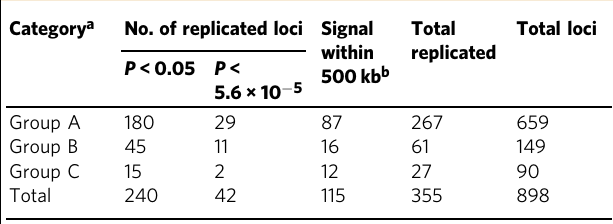
Fig. 5 Performance of European-derived polygenic scores in QGP. Pearson ’ s correlation (R) between polygenic scores (PGS) and trait values are shown for European populations (red) and Qatari population (blue). Weighted PGS scores were based on those derived from European